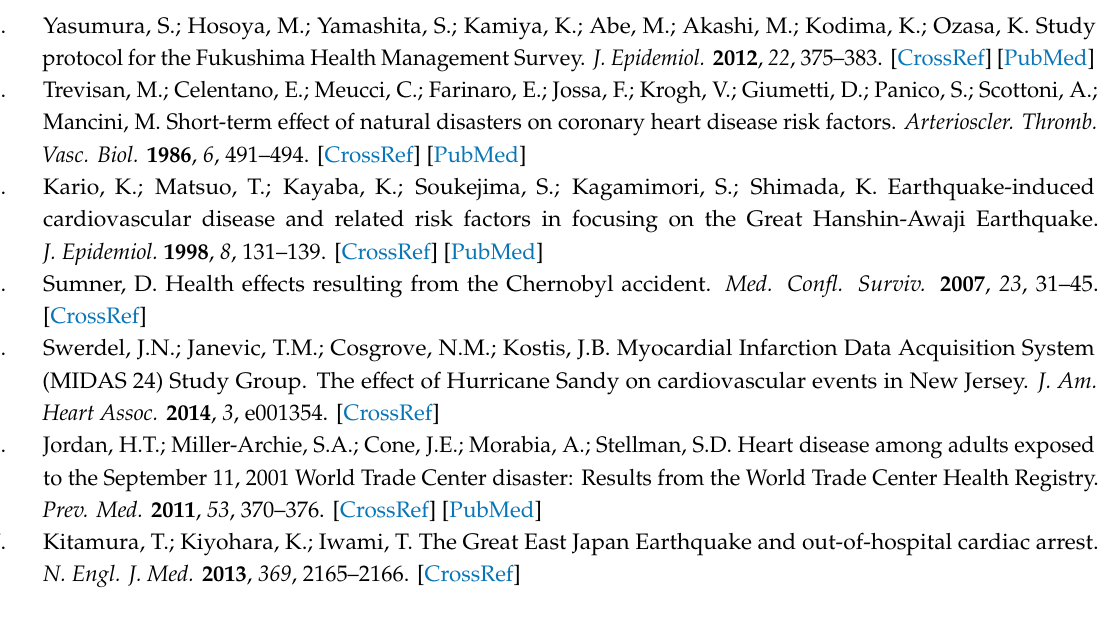
Table S1: Gender-specific age-adjusted and multivariable HRs (95% CIs) of CVDs according to evacuation status. Author Contributions: Conceptualization, methodology and formal analysis, T.S., E.E. and T.O.; validation, F.H., E.E. and T.O.; investigation and data curation, T.O., M.M., S.Y., Y.S., H.Y., A.T., K.T. M.H. and K.K.; resources, T.O., M.M., S.Y., Y.S., H.Y., A.T., K.T., M.H., T.H., K.O., H.K. and K.K.; writing and visualization, T.S. and E.E.; supervision, E.E. and T.O.; project administration and funding acquisition, T.O., M.M., S.Y., H.K. and